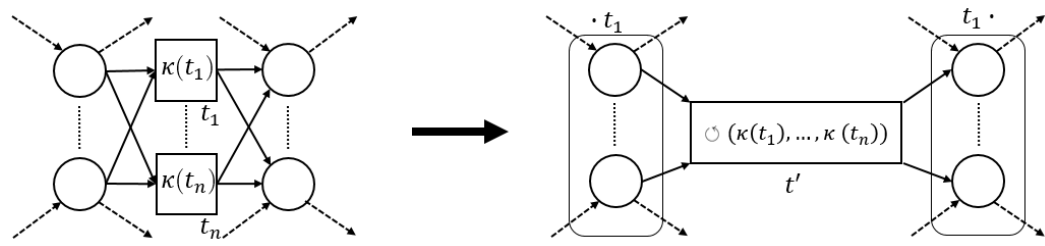
Figure 12. Visualization of the (cid:9) -pattern reduction. The pre-set of transition t 1 equals the post-set of t 2 and vice versa. The replacing transition inherits the pre- and post-set of transition t 1